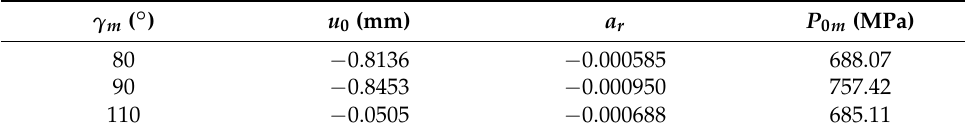
Table 11. Optimization results for different shaft angles γ m .